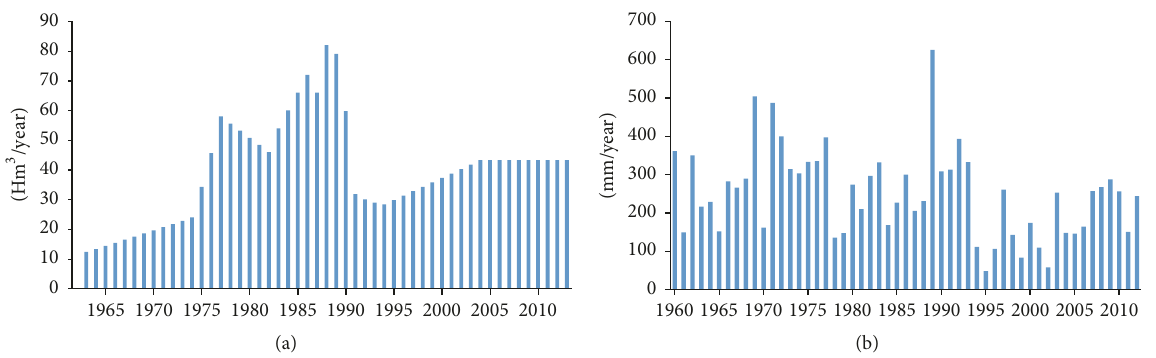
Figure 3: (a) Wells extraction rate. Maximum extractions of 80 hm3 reached in 1987 were drastically reduced after 1989 restrictions. (b) Rainfall series from Spanish Meteorological Survey. Two dry periods are clearly represented from 1994 to 2003.